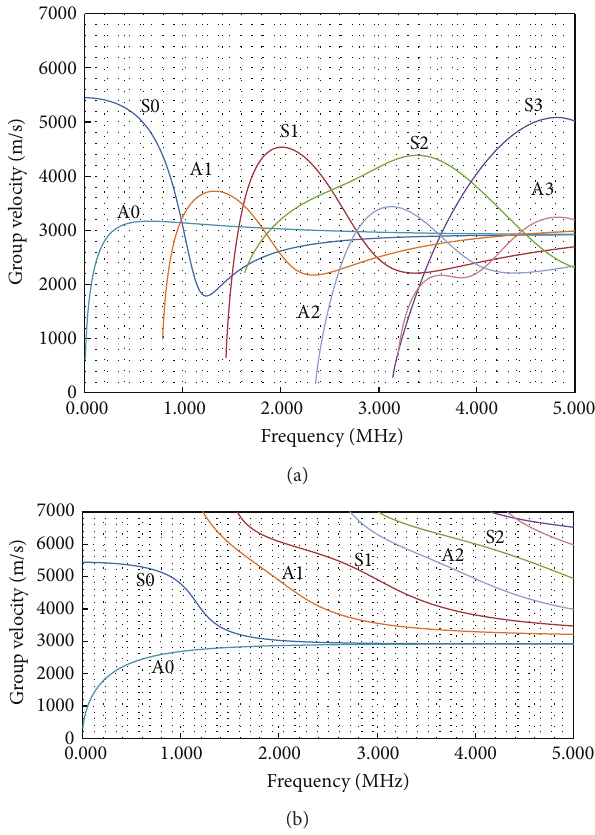
Figure 2: (a) Group velocity dispersion curves. (b) Phase velocity dispersion